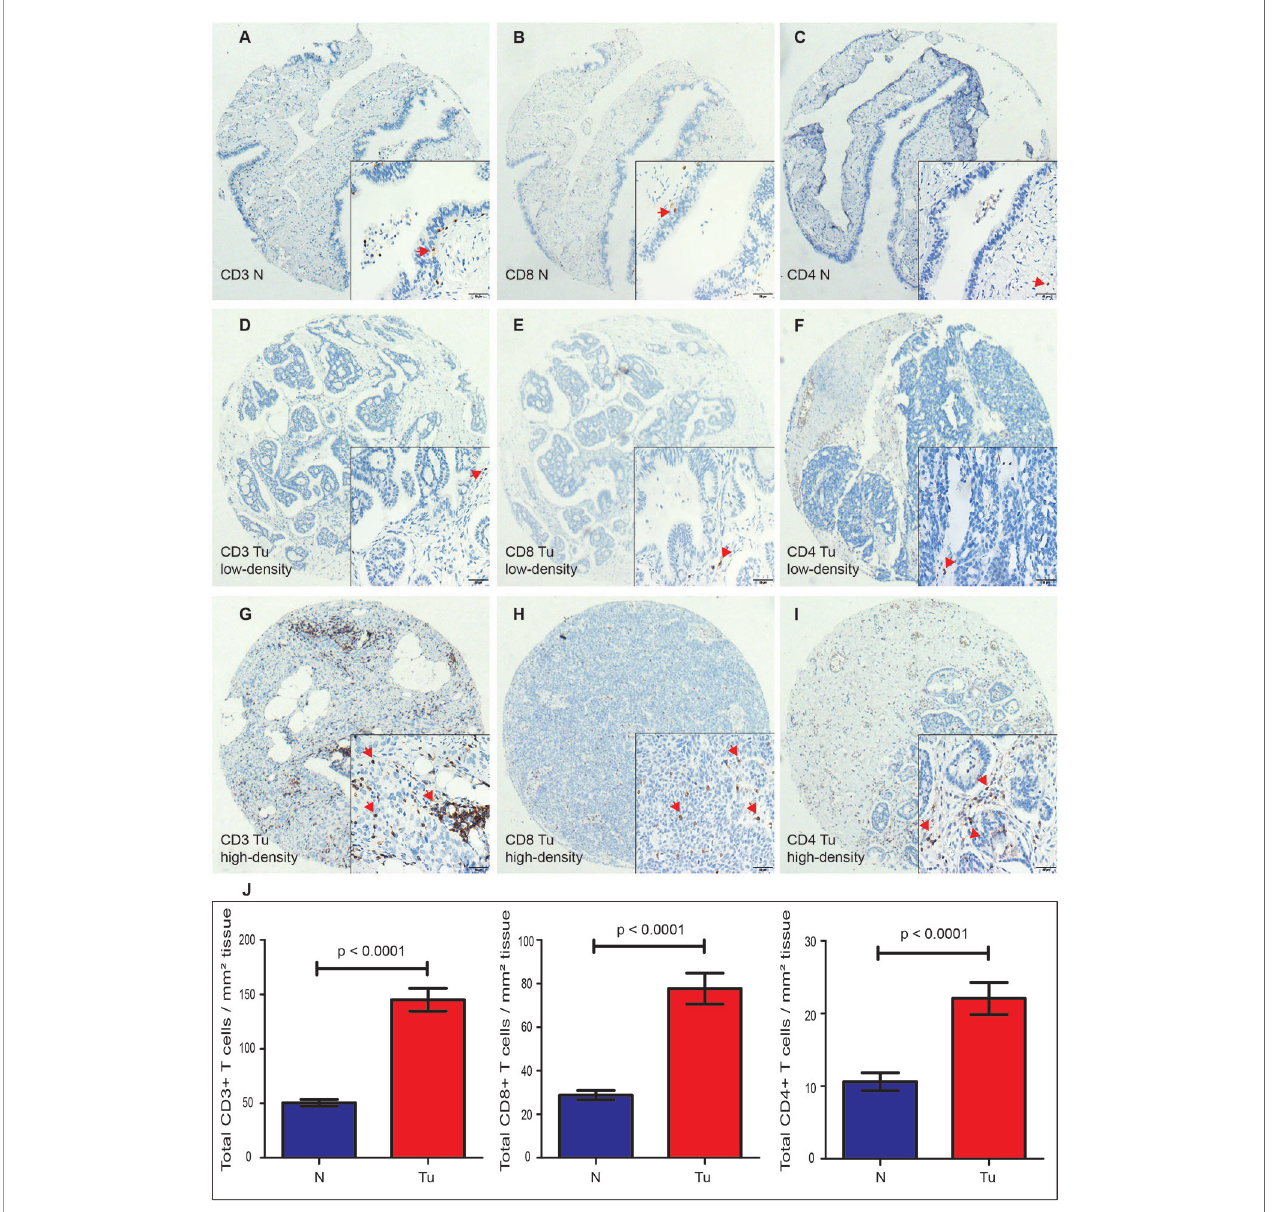
FIGURE 1 | Expression of CD3+, CD8+, and CD4+ TILs in HGSOC tissues (Tu) and matched normal epithelium of the fallopian tubes (N), shown at 40× magni fi cation with inset (400×). (A – C) Representative images of CD3+, CD8+, and CD4+ TILs in the normal fallopian tube tissues. (D, G) Representative images of low-density and high-density of CD3+ TILs in the HGSOC tissues. (E, H) Representative images of low-density and high-density CD8+ TILs in the HGSOC tissues. (F, I) Representative images of low- density and high-density of CD4+ TILs in the HGSOC tissues. (J) Box plots of CD3+, CD8+, and CD4+ TILs per mm 2 in tumor tissues (n=197) or normal epithelium of the fallopian tubes (n=173). Quantitative data are presented as mean ± SEM. TILs, tumor-in fi ltrating lymphocytes; HGSOC, high-grade serous ovarian